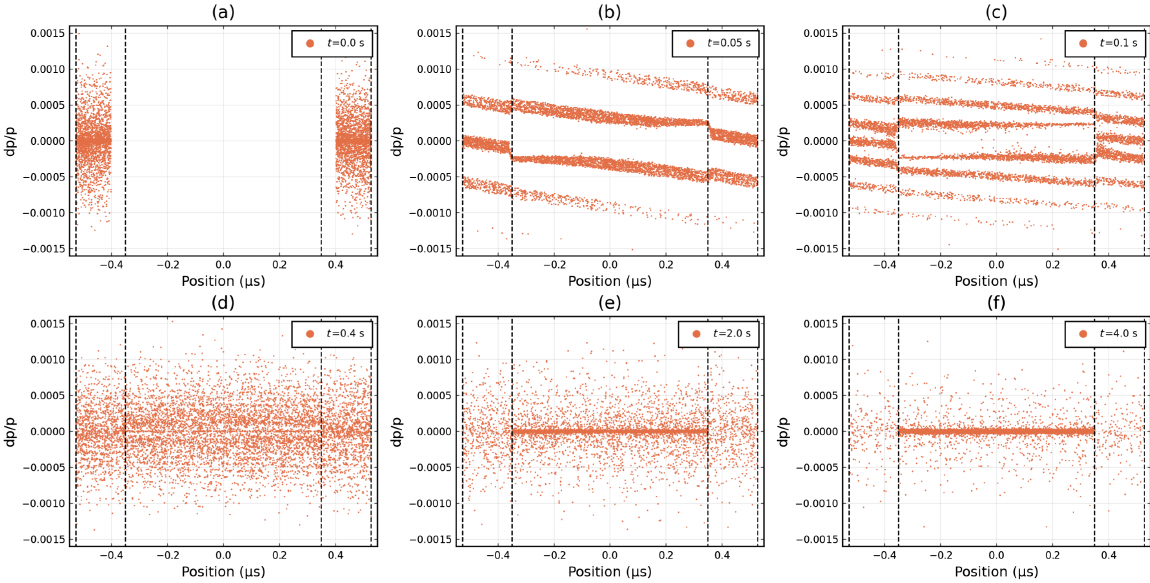
FIG. 5. Simulation results of beam distribution in longitudinal phase space during cooling. The boundaries of the ring and the pulsed electron beam are marked with a dashed line. (a) After injection of a short bunched ion beam (uniform); (b – c) The debunching process due to drift motion, no obvious cooling effect is observed yet; (d) Debunching finished and particles start to be bunched into the bucket due to cooling; (e, f) Ion beam is gradually cooled and bunched into the